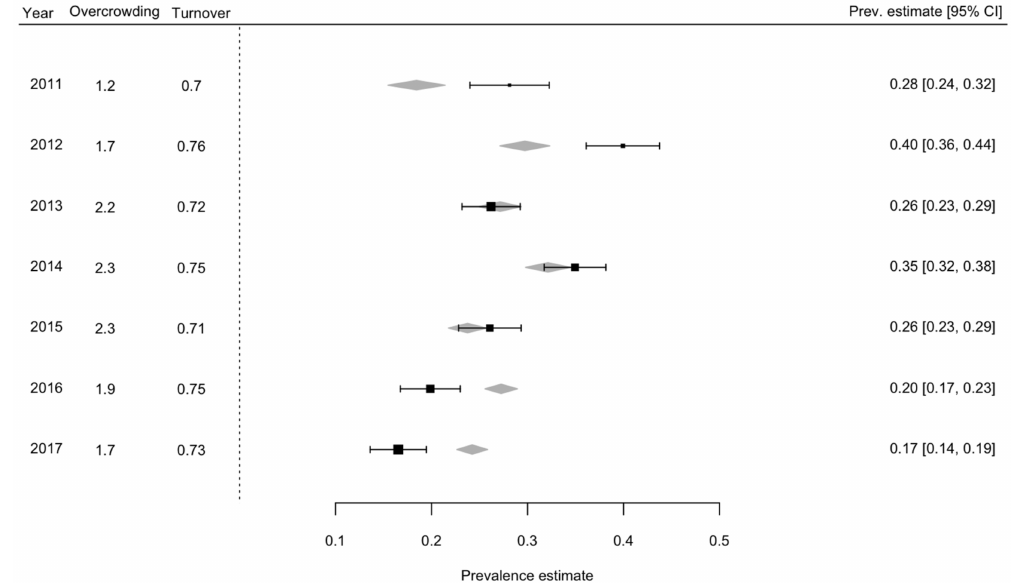
Figure 2. Forest plot of self-harm over seven years at the Champ-Dollon